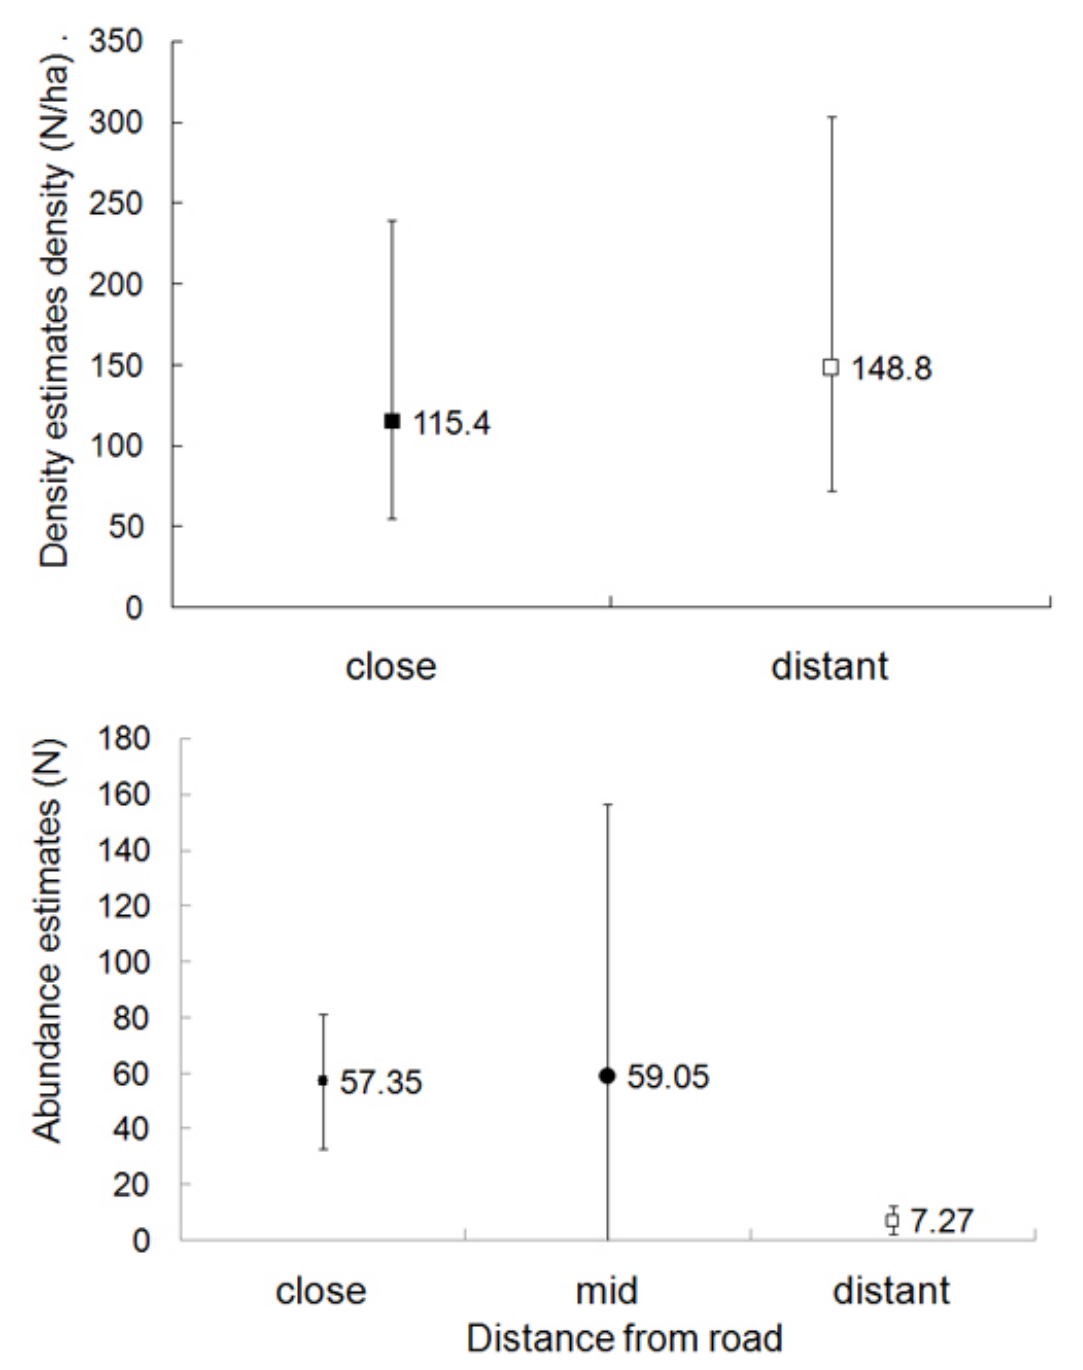
Figure 3. Density and abundance estimates of small mammals (95% confidence intervals) at different distances from the I-15 in southern Utah, USA, in: (a) 2004 and (b)